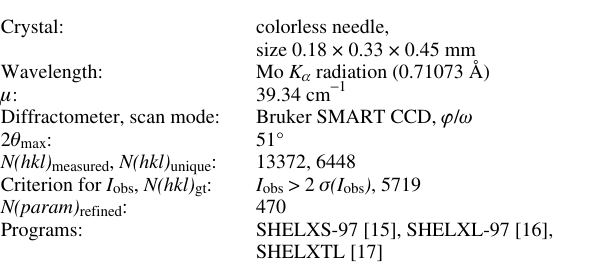
Table 1. Data collection and